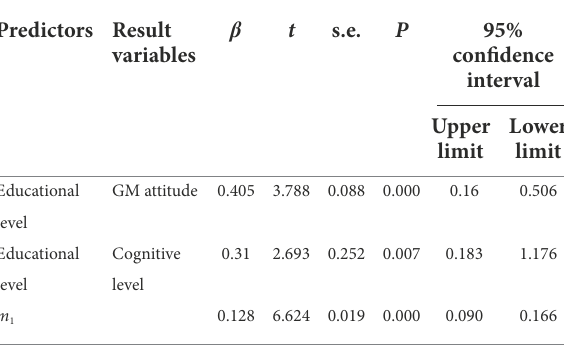
TABLE 1 Mediating effect analysis.